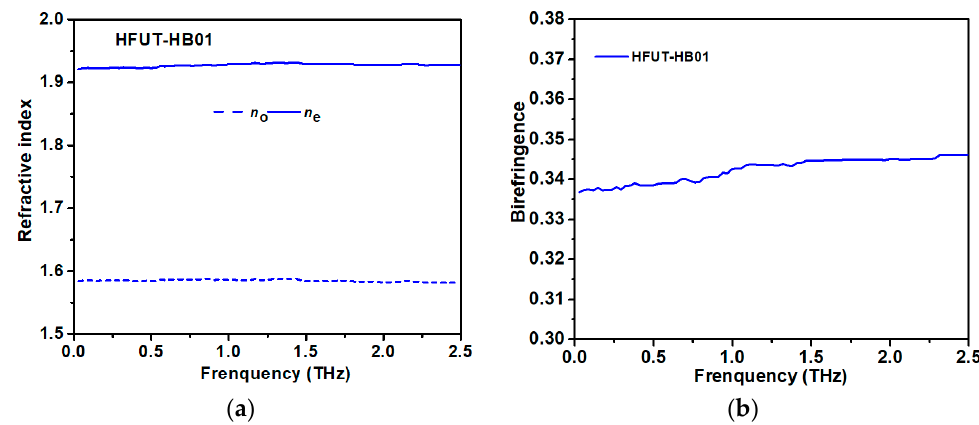
Figure 3. ( a ) Refractive index of liquid crystals at T = 25 °C; ( b ) Birefringence of liquid crystals at T = 25 °C.